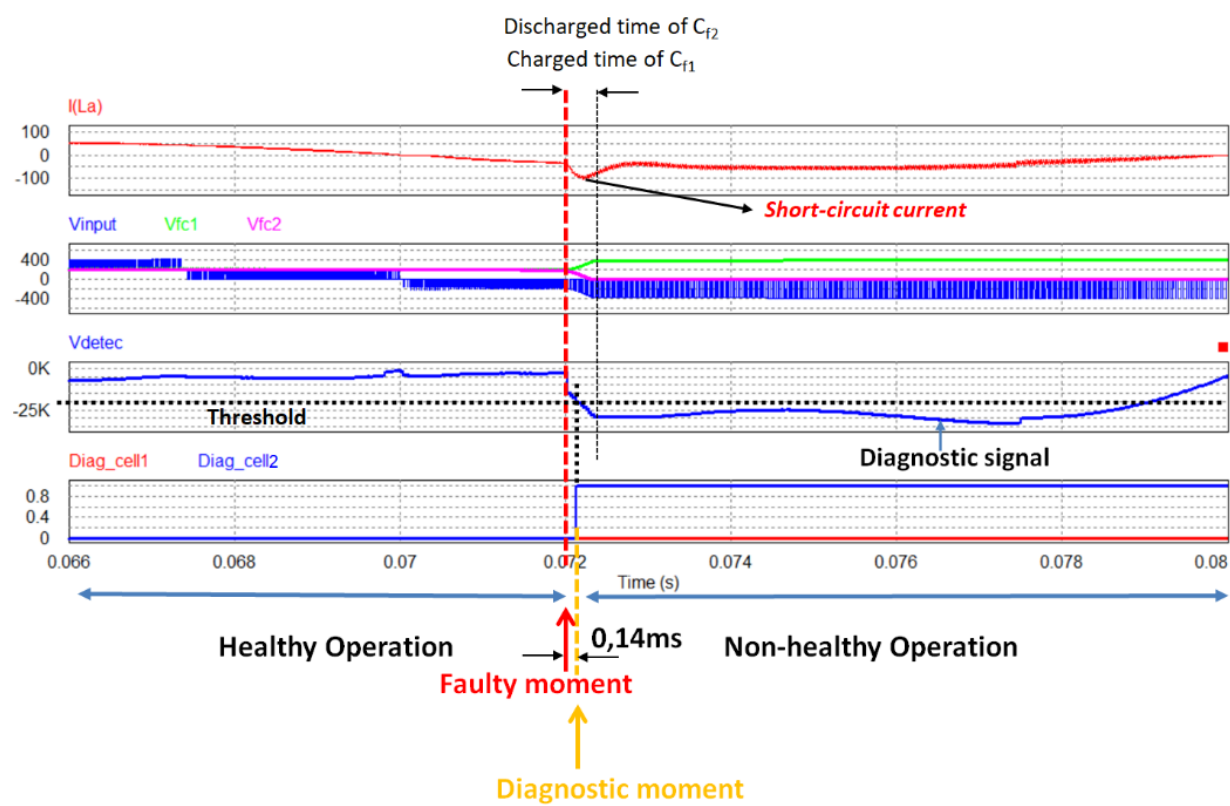
Figure 13. Diagnostic simulation results with a short-circuit on T 2.